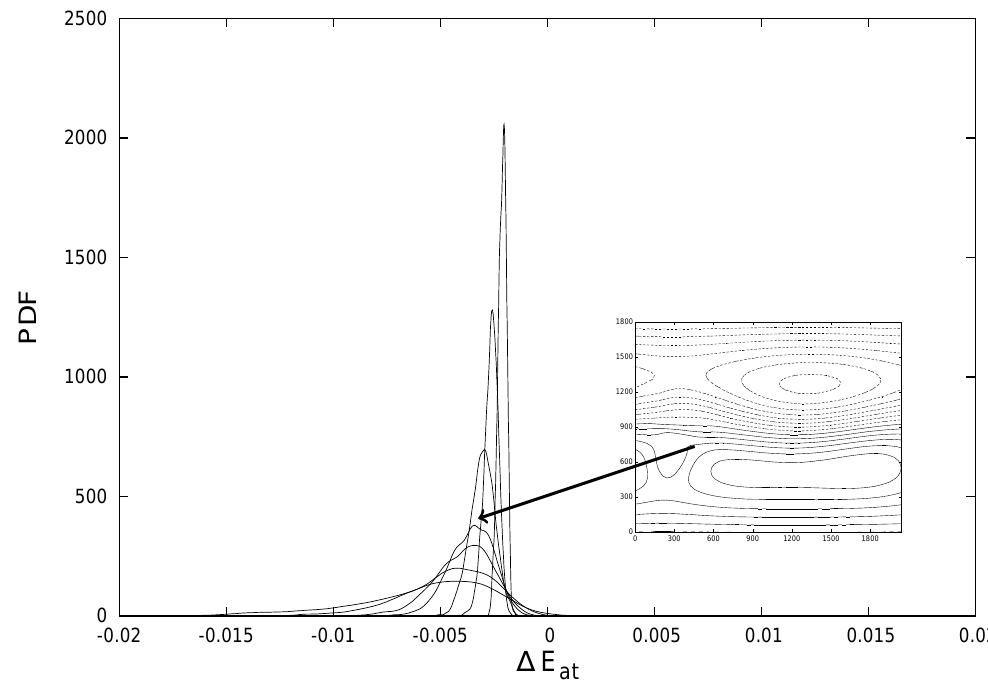
Fig. 13. Same as Fig. 12 but with an asymmetric SST field, shown in Fig. 3b. The insert is the mean state of the time series for α = 0 . 1.